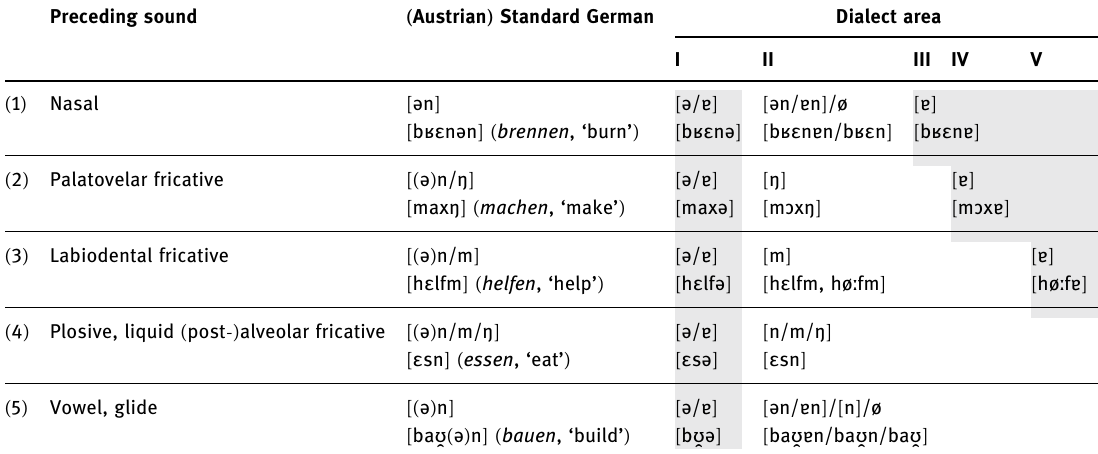
Table 1: Prototypical realisations of ( en ) in individual dialect areas as documented by traditional dialectology ( Kranzmayer 1956 and Wiesinger 1989